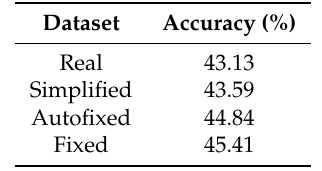
Table 8. Results for error-corrected